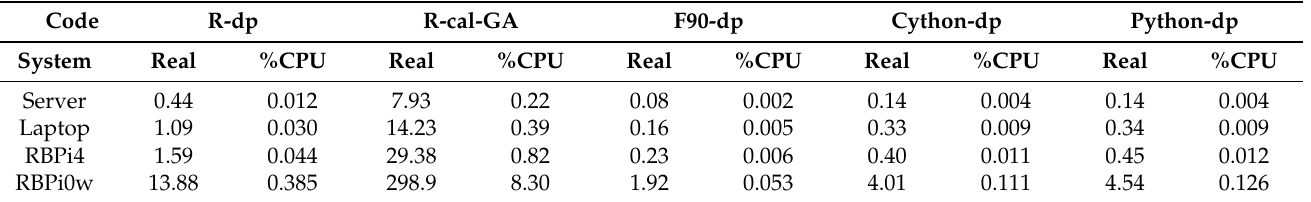
Table 2. Real time [seconds], and %CPU execution time for a period of one hour, of the codes for the calibration stage (R-cal-GA) and the data acquisition and process stages (R-dp, F90-dp, Cython-dp and Python-dp) in four computing